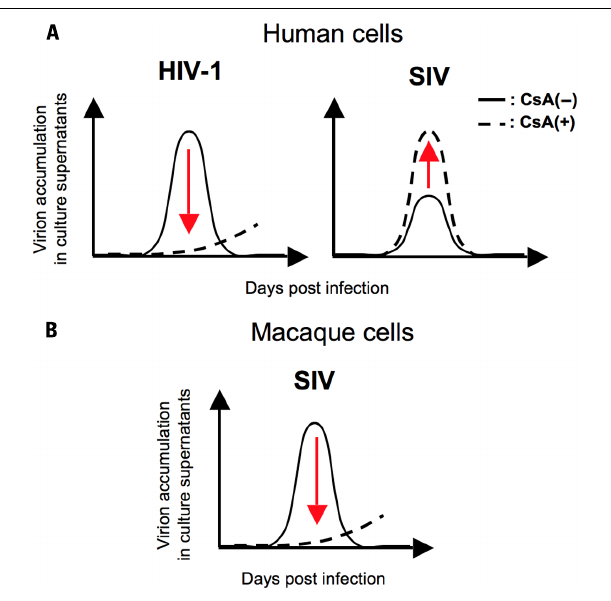
FIGURE 1 |A schema for the effect of CsA on HIV/SIV replication in human/macaque cells. (A) CsA treatment impairs the replication of HIV-1 (left panel) but enhances SIV replication (right panel) in human cells. (B) CsA treatment inhibits SIV replication in macaque cells.The solid line indicates virion accumulation of culture supernatant in the absence of CsA and the broken line indicates that of culture supernatant in the presence of CsA.